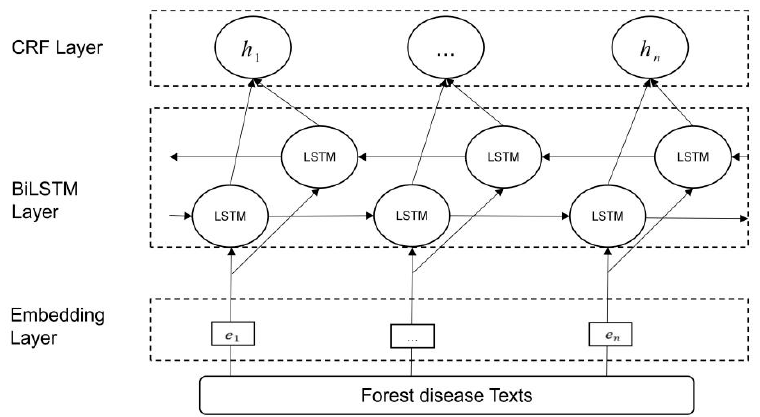
Figure 4. The structure of BiLSTM-CRF method.